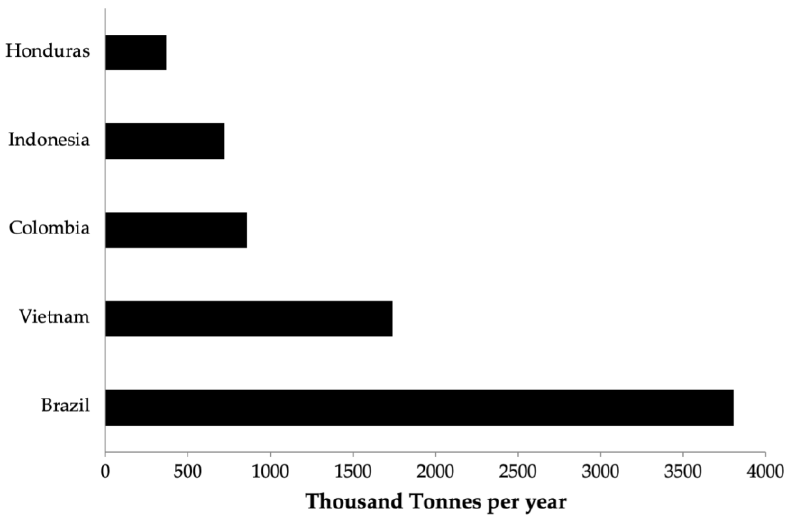
Figure 1. Coffee production by country [4].